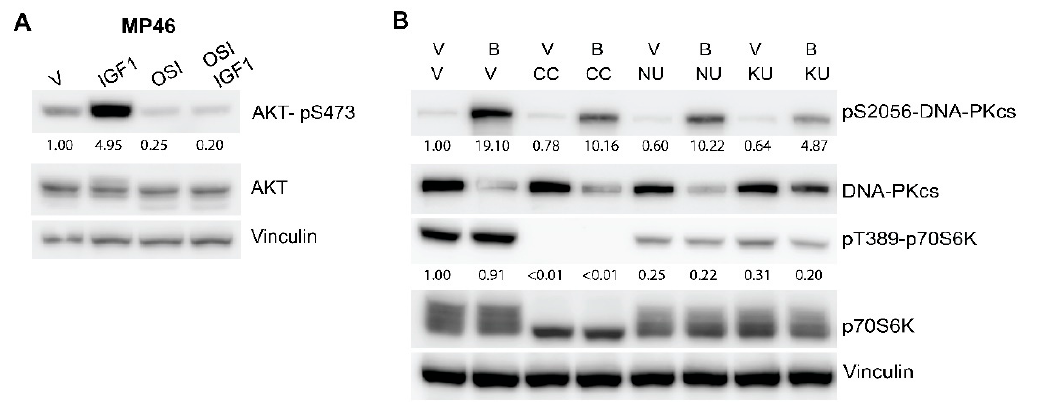
Figure 4. Target engagement of the selected inhibitors. ( A ) Treatment with OSI-906 abolished the IGF1-induced phosphorylation of AKT at Ser473. MP46 cells were pre-treated with 4 µM OSI-906 (OSI) or vehicle (V) for 6 h and subsequently stimulated with 15 ng/mL IGF1 for 20 min. ( B ) Treatment with DNA-PK inhibitors reduced the activation of DNA-PKcs by bleomycin. MP46 cells were pre-treated with either vehicle (V), 2 µM CC-115 (CC), 10 µM NU7026 (NU), or 5 µM KU57788 (KU) for 2 h. After addition of 2 µM bleomycin ( B ) the cells were incubated for 4 h and harvested for analysis. Quantifications were performed with the Image Lab 6.0 program. Raw values were normalized to vinculin values, and subsequently, relative values compared to untreated cells were cal- culated.